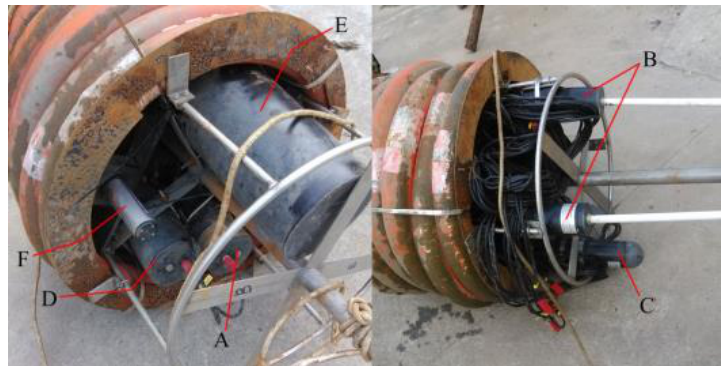
Figure 6. The moored platform consists of: ( A ) a data logger, ( B ) two wireless devices, ( C ) a GPS device, ( D ) two interface extension modules, ( E ) the system power supply, and ( F ) fluorometers.